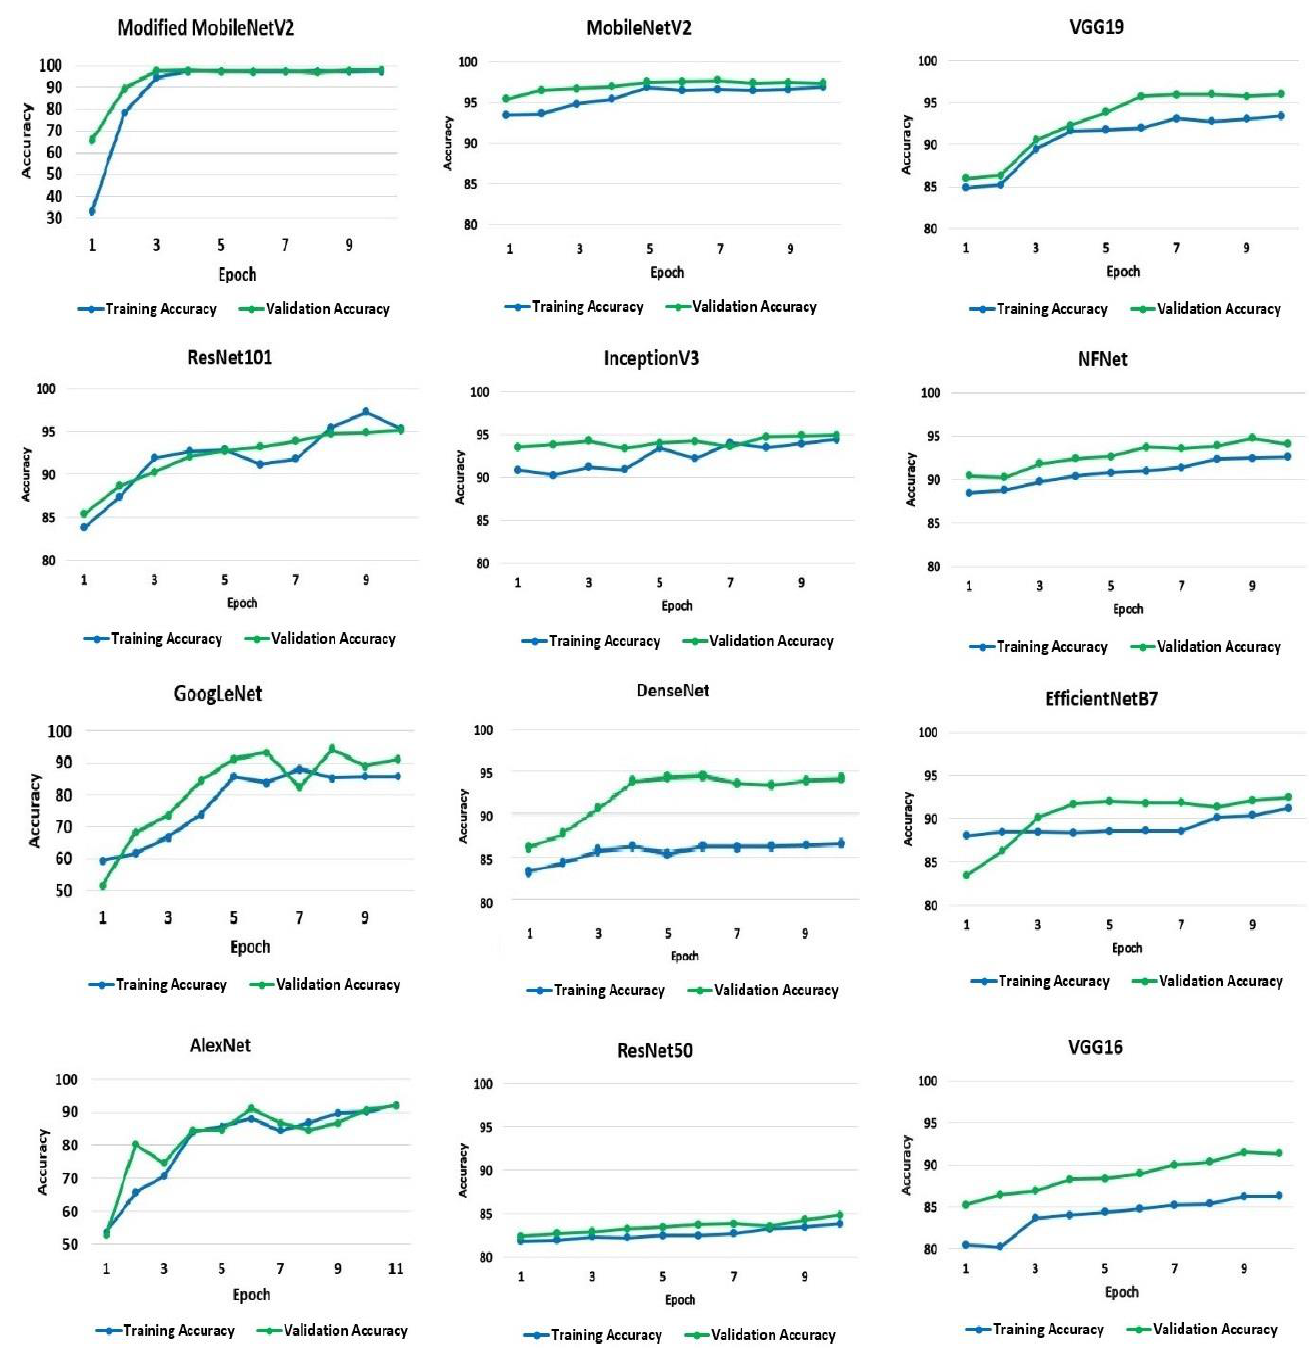
Figure 4. Training and validation accuracy of the models.